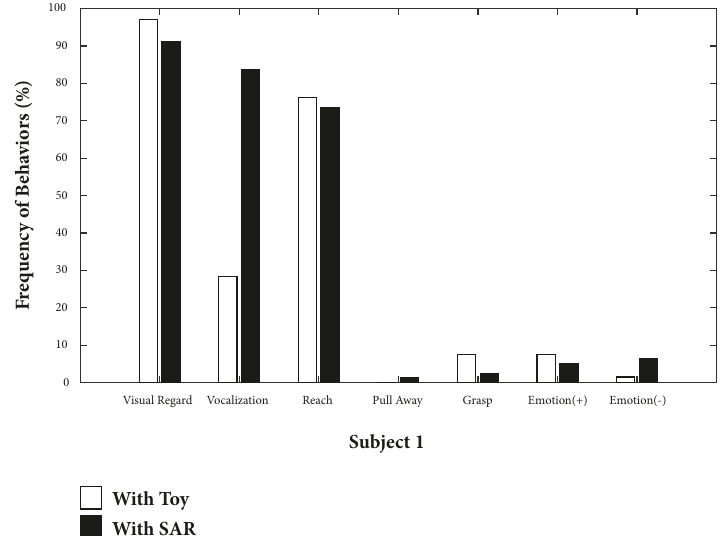
Figure 5: Results for Subject 1, which show a higher level of interaction with the SAR over the switch-adapted toy, shown most clearly in frequency of